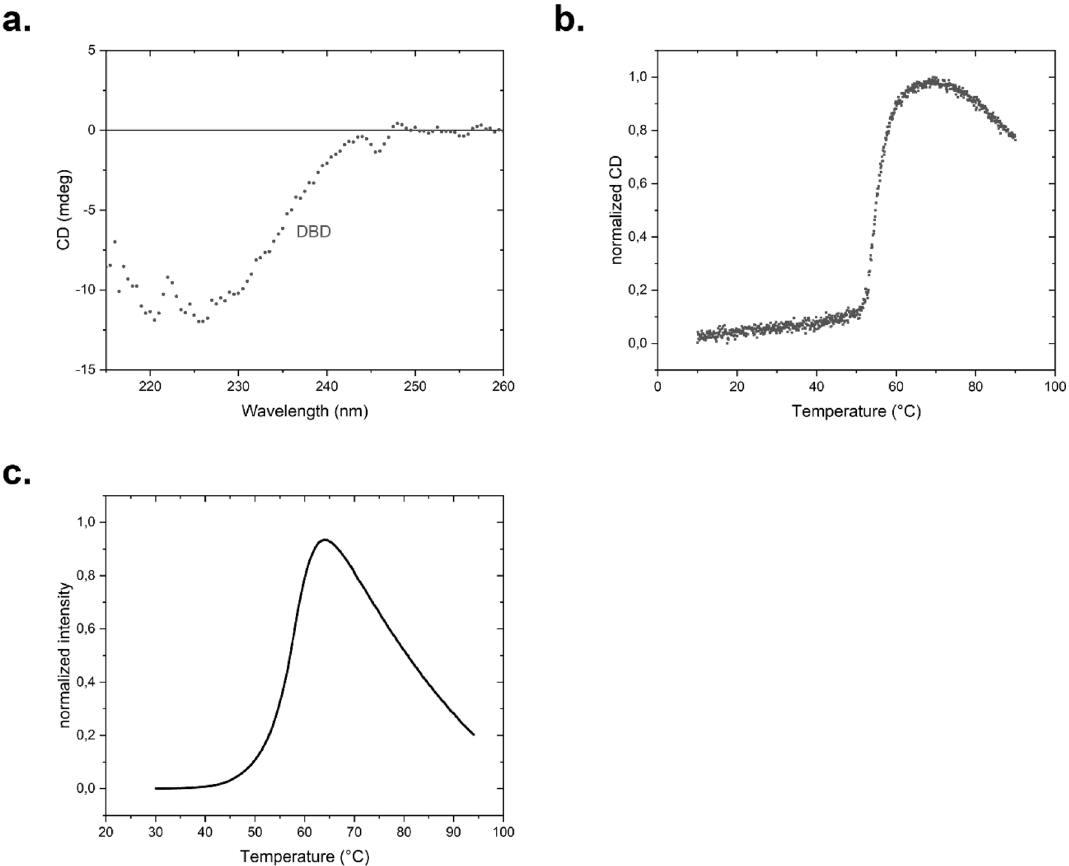
Figure 2. Structure and stability of HSF-1 DBD fragment 82–198. ( a ) CD-spectroscopy, ( b ) unfolding, determined by a thermal transition with CD-spectroscopy and ( c ) unfolding, determined by a thermal shift